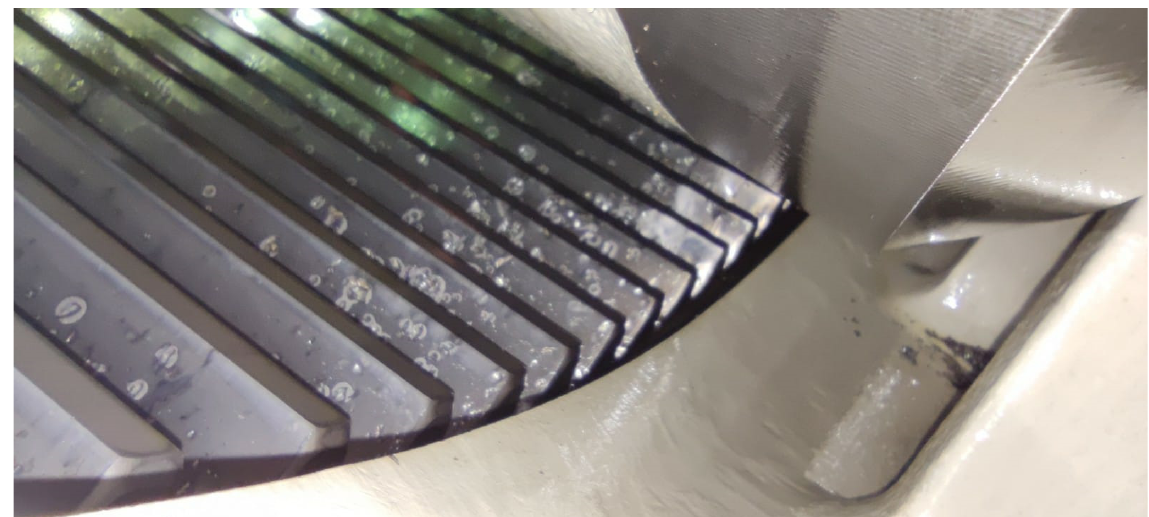
Figure 6. The effect of planetary gear teeth wear in wind turbines in the form of spots caused by gases released inside the nacelle.